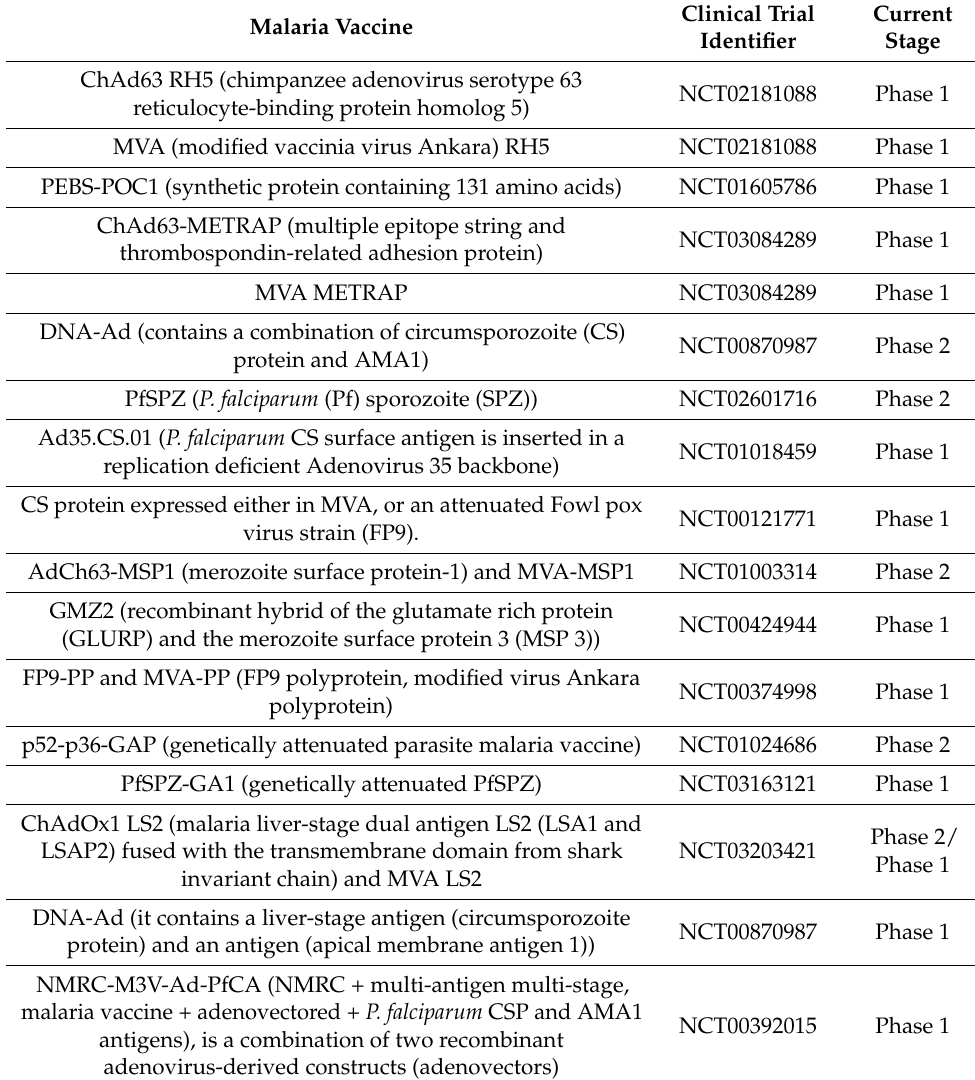
Table 1. List of vaccines under clinical testing without specific vaccine